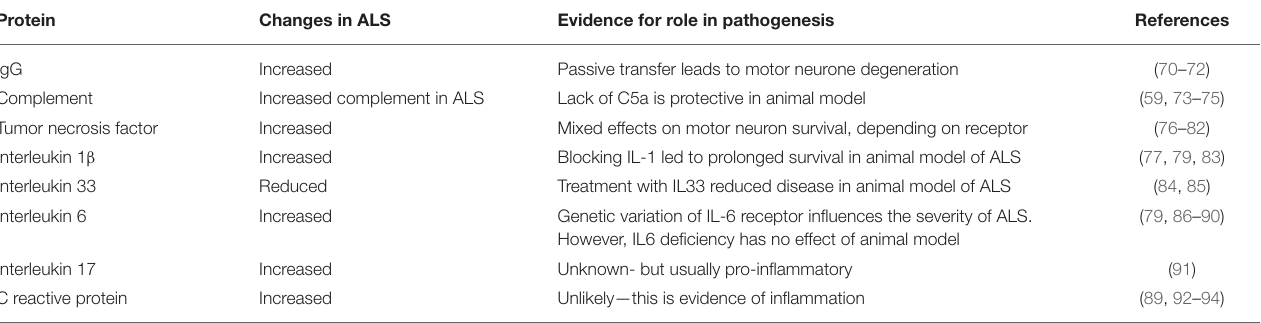
TABLE 2 | Changes in peripheral blood proteins in